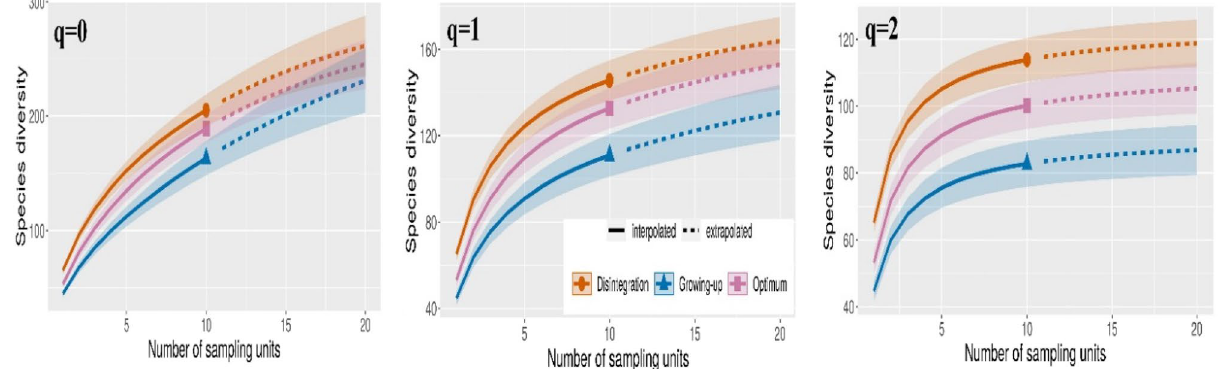
Figure 10. Species gamma diversity curves split separately by cycles divided into Hill’s numbers q = 0 (species richness), q = 1 (exponential of Shannon’s entropy index), and q = 2 (inverse of Simpson’s concentration index). The curves were extrapolated by the same number of samples, the colored shaded areas are the 95% confidence interval. Solid symbols represent the total number of study samples.